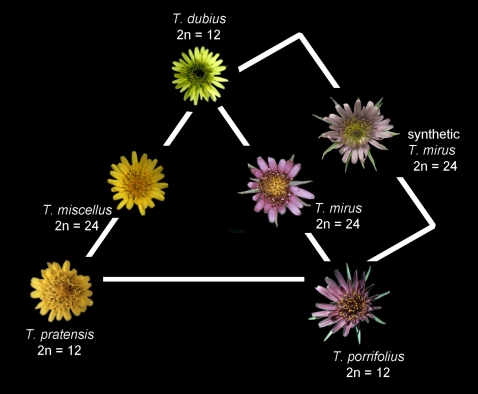
Tragopogon triangle with the flowers of the diploid Tragopogon species at the apices of the triangle.The flowers of the polyploids T. miscellus and T. mirus are shown between their respective diploid parents. The synthetic polyploid described here has the same parents as T. mirus.